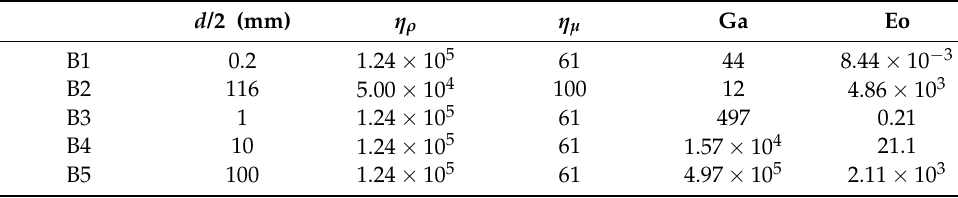
Table 13. Parameters for the H rising bubble in PbLi